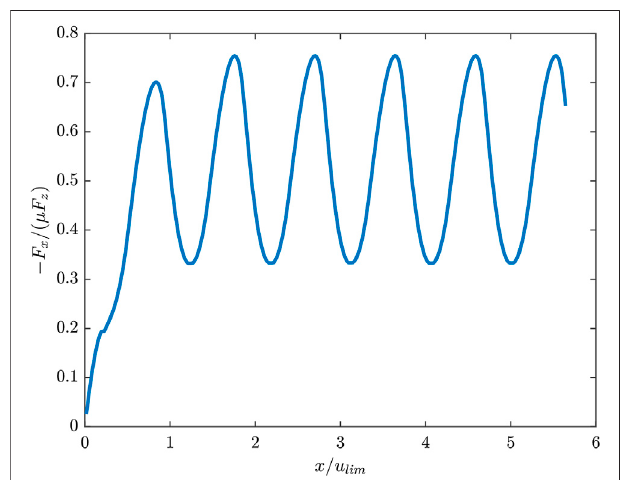
FIGURE 1 | Dependency of the normalized tangential force on the displacementwhentransverseoscillationsareapplied.Here ~ v 0 (cid:2) 0 . 3and ~ y 0 (cid:2) 1 . 6 were chosen. The resulting effective coef fi cient of friction is ~ μ macro ≈ 0 .